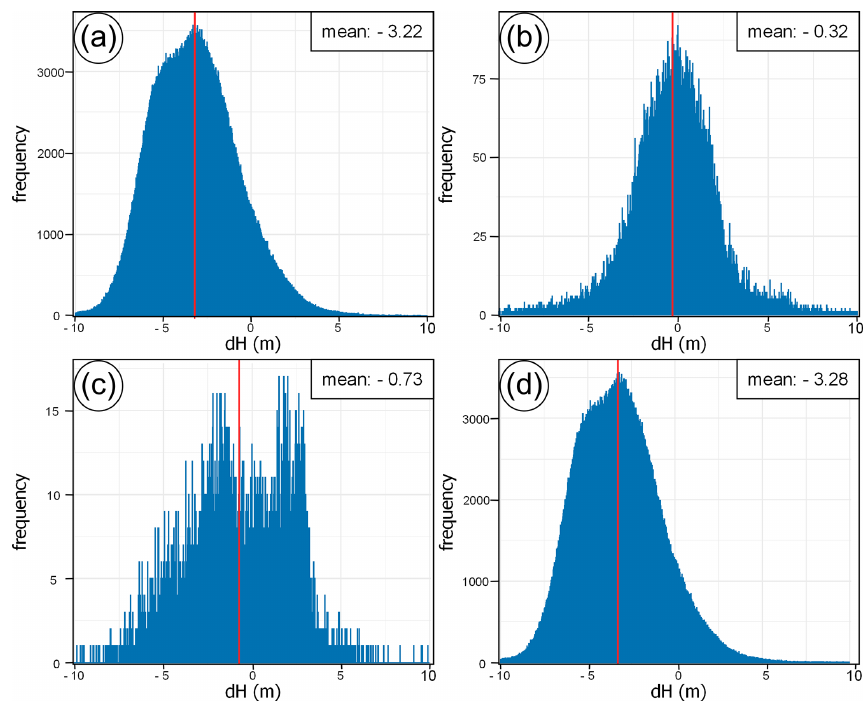
Figure 12. Histograms of height differences of TanDEM-X DEM minus (a) all ICESat elevations, (b) ICESat elevations on blue ice areas, (c) ICESat elevations on ice-free rocks, and (d) ICESat on snow/firn. Assigned according to the land cover map of Hui et al. (2017a).